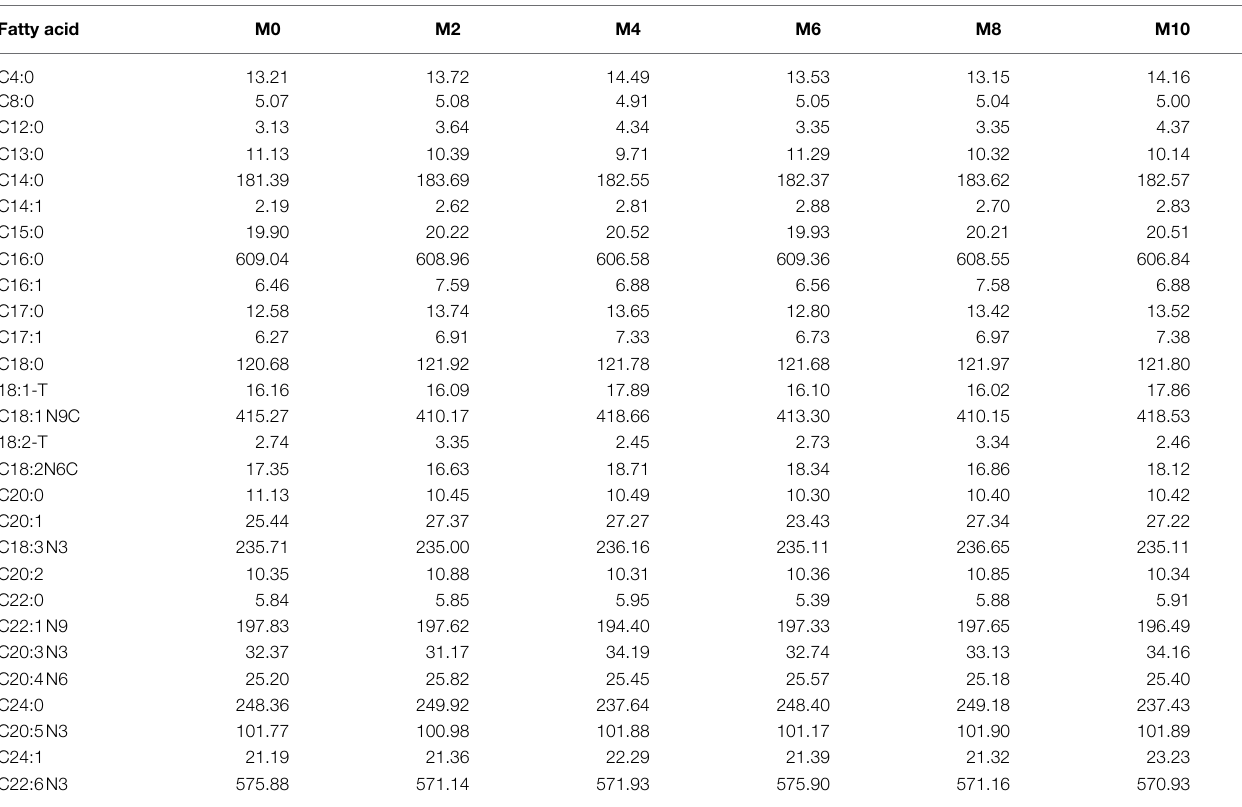
TABLE 3 | The fatty acid content (mg/100 g) of the six experimental diets.